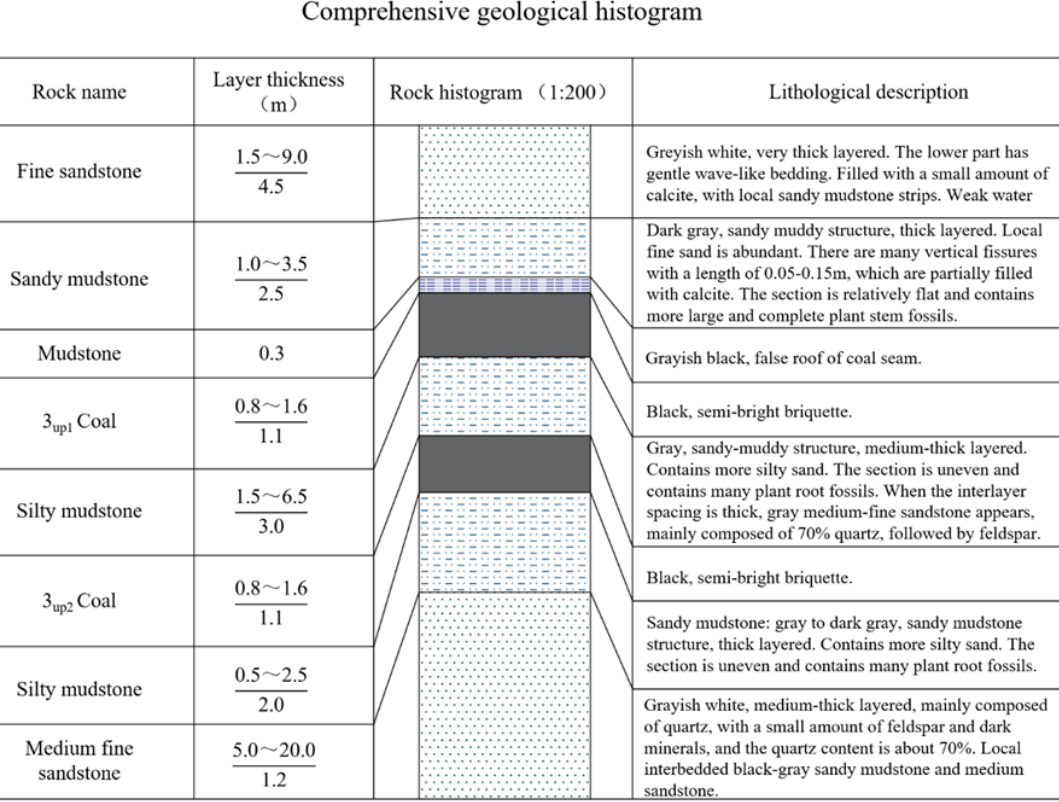
Figure 5. Comprehensive geological histogram.